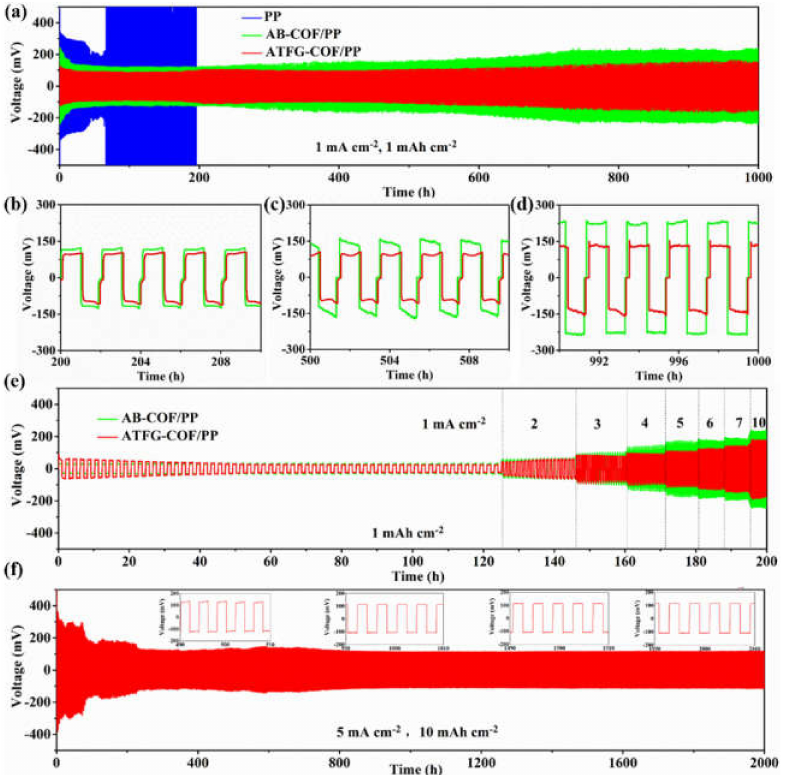
Figure 4. ( a ) Li-Li symmetric batteries with ATFG-COF/PP, AB-COF/PP, and PP at 1 mAh cm − 2 and 1 mA cm − 2 ; ( b – d ) amplifying the voltage platform in different cycles; ( e ) Li-Li symmetric batteries with ATFG-COF/PP, AB-COF/PP and PP at 1 mAh cm − 2 and different current densities; ( f ) Li-Li symmetric batteries with ATFG-COF/PP at 10 mAh cm − 2 and 5 mA cm − 2